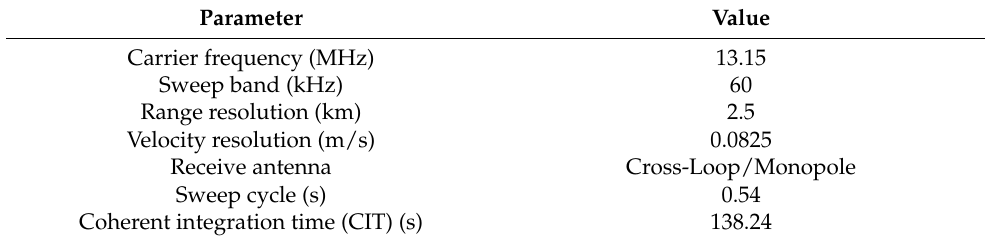
Table 2. HFSWR Table 2. HFSWR parameters.